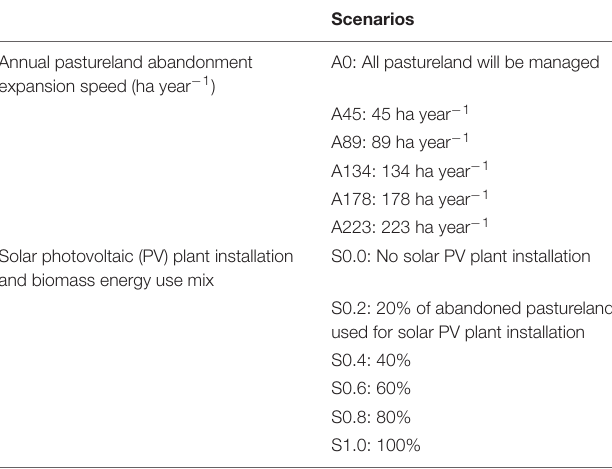
TABLE 1 | Pastureland management and renewable energy introduction scenarios.